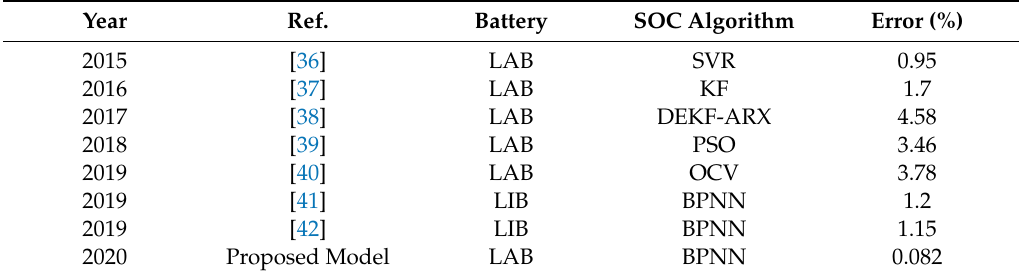
Figure 15. Root mean square error (RMSE) of the system. Table 1. Comparison of SOC estimation